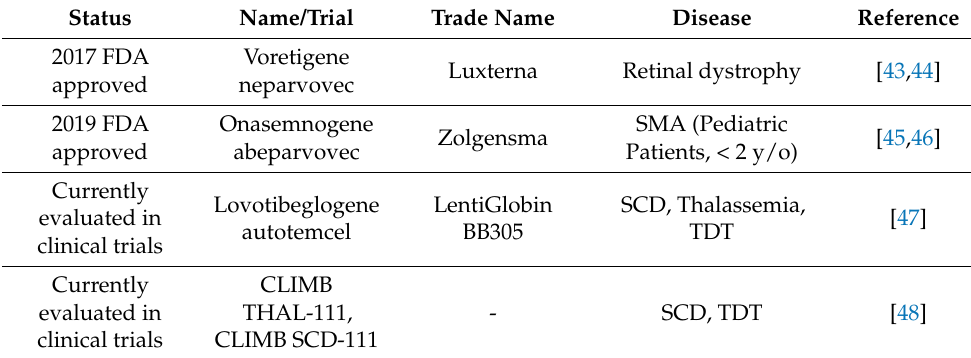
Table 2. CRISPR in clinical